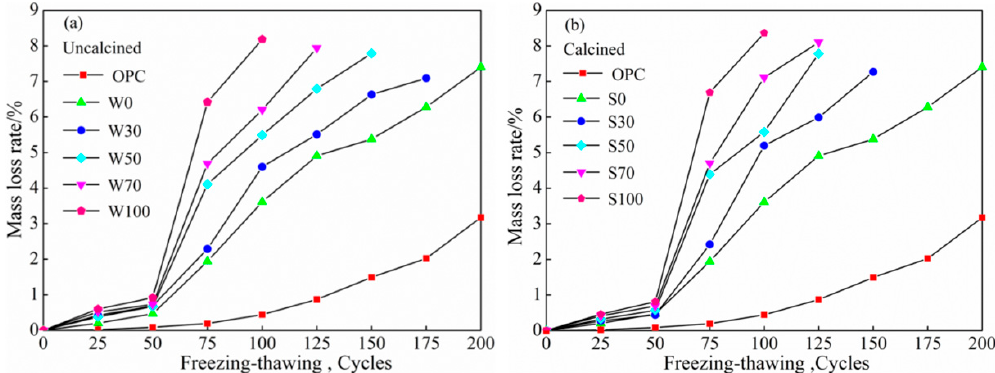
Figure 5. The relationship between the number of freezing-thawing cycles and the mass-loss rate of ( a ) uncalciend and ( b ) calcined.